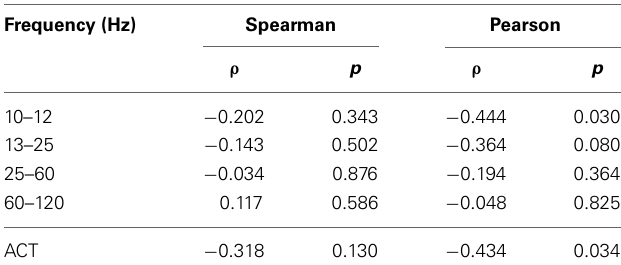
Table 1 | Correlation coefficients between AIS and spectral power, and autocorrelation decay time (ACT) in the hippocampal source. Frequency (Hz) Spearman